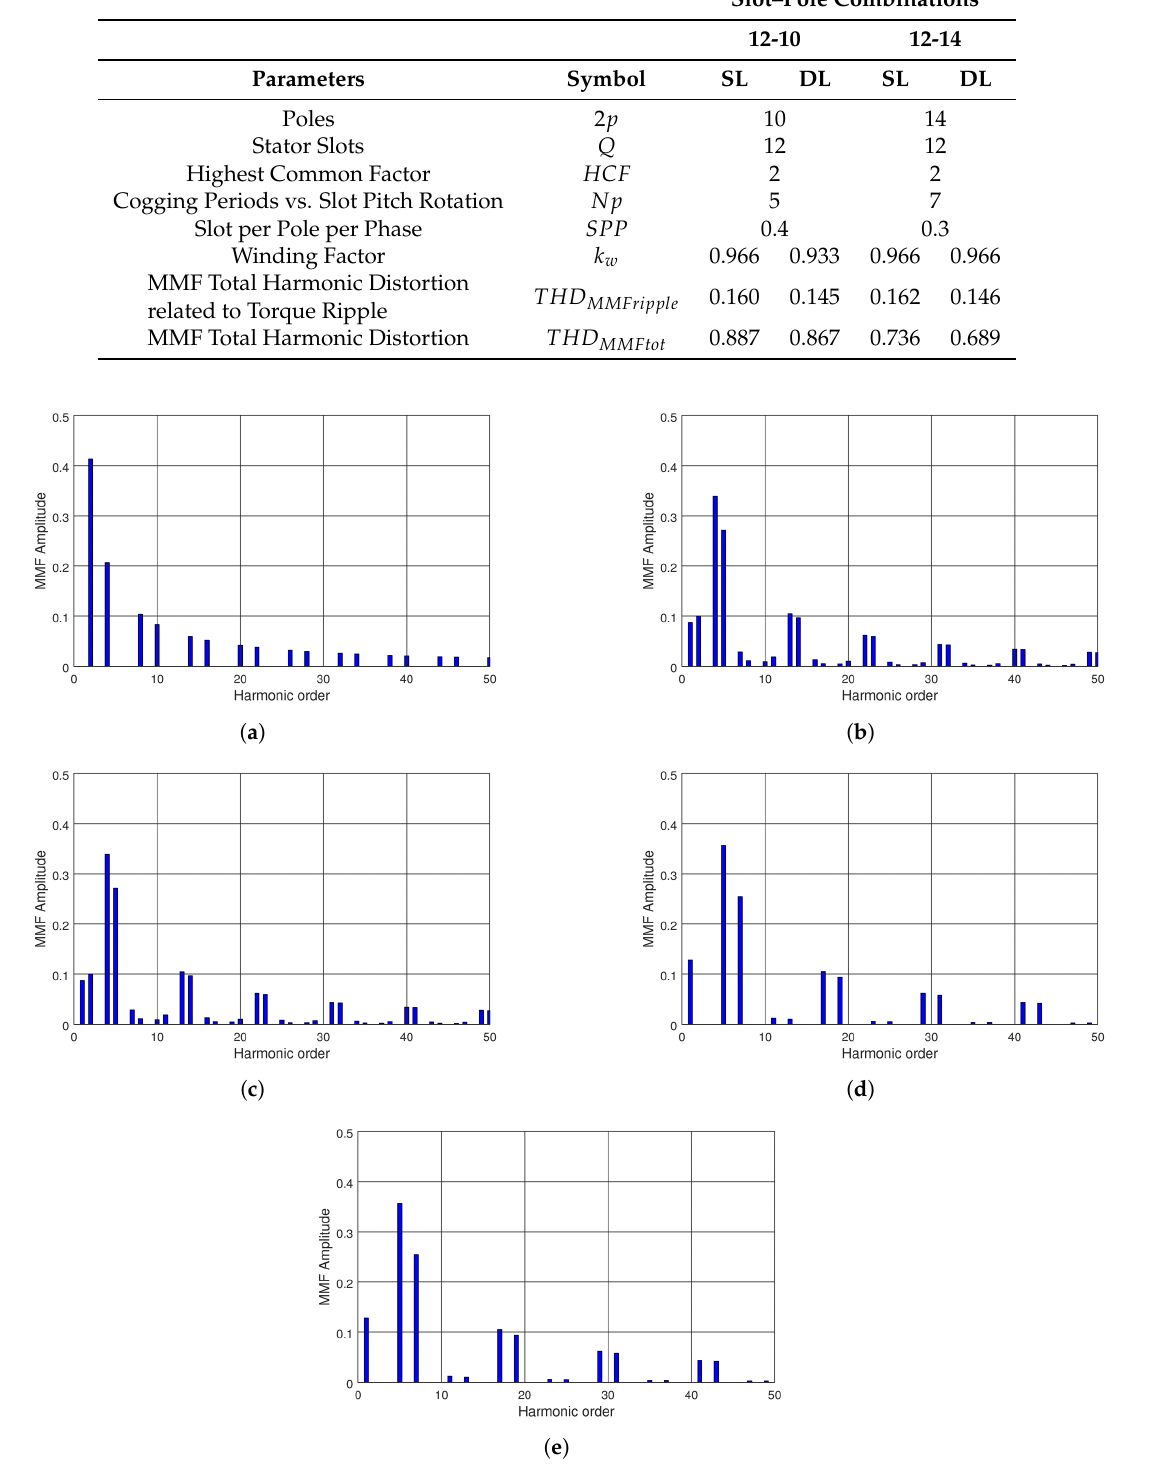
Table 3. Analyzed slot–pole combinations (b).